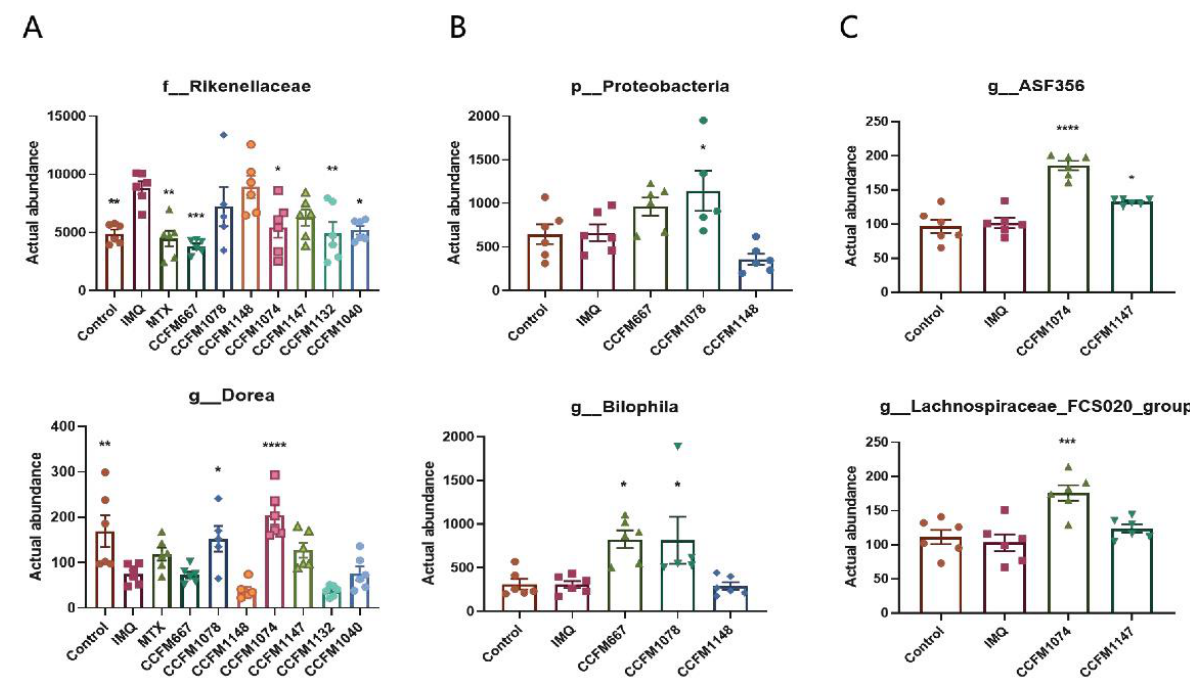
Figure 9. Difference analysis of gut microbiota between groups ( n = 5/6). The abundance of key differential gut microbiota between ( A ) the control and IMQ groups, ( B ) the Bifidobacterium CCFM1078, CCFM667, CCFM1148 groups, ( C ) the L. paracasei CCFM1074 and CCFM1147 groups. * p < 0.05, ** p < 0.01, *** p < 0.001 and **** p < 0.0001.